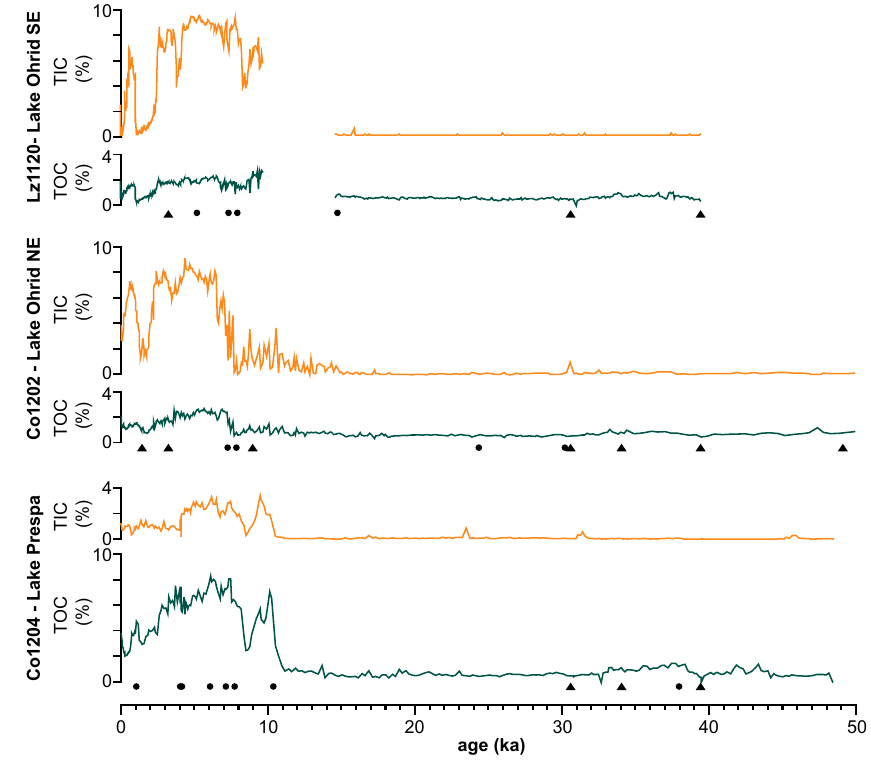
Fig. 4. Comparison of total organic carbon (TOC) and total inorganic carbon (TIC) in cores from Lake Prespa (Co1204) and Lake Ohrid (Co1202 and Lz1120). For location of the cores see Fig. 1. Black dots and triangles in the cores from lakes Prespa and Ohrid indicate horizons, which were used for radiocarbon dating and